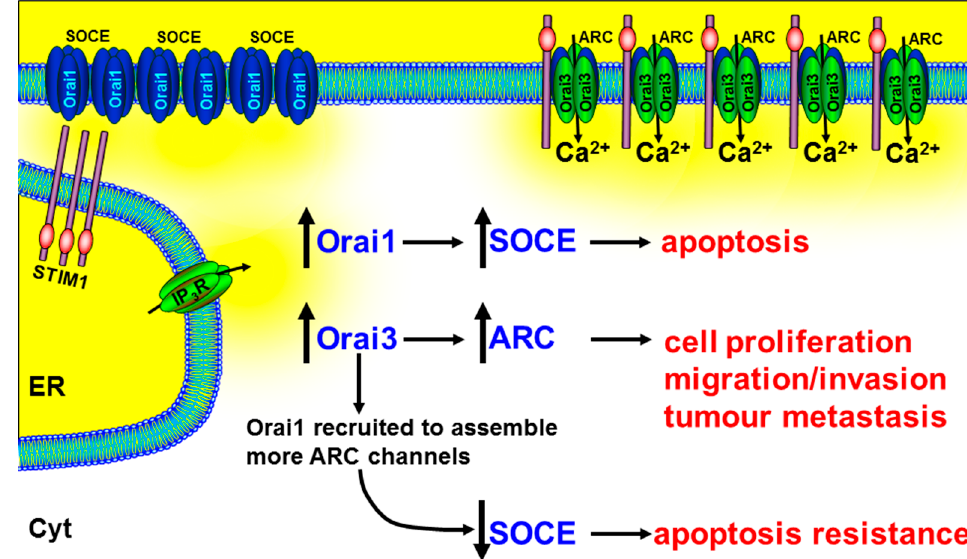
Figure 5. The role of Orai3 and ARC channels in numerous cancer hallmark responses. Arachidonate- regulated Ca 2+ entry channels (ARC) consist of heteropentameric subunits of Orai1 and Orai3. The increase in Orai3 expression and/or change in the tumour microenvironment (arachidonic acid) lead to the recruitment of Orai1 subunits into the assembly of heteropentameric Orai1/Orai3 ARC channels and a corresponding decrease in available Orai1 subunits for the assembly of SOCE channels. The increase in the ARC channels leads to the NFAT-dependent cell proliferation, migration/invasion, and tumour metastasis, and the reduction in SOCE leads to apoptosis resistance. This suggests that drugs designed to specifically inhibit Orai3, or their assembly with Orai1, might inhibit tumour growth and metastasis, while simultaneously promoting